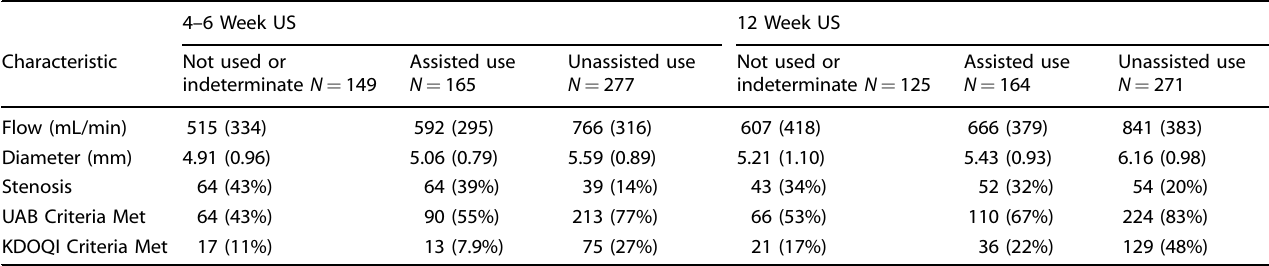
Table 2. Successful radiocephalic arteriovenous fi stula use at 1-year by ultrasound parameters at 4 – 6 weeks and 12